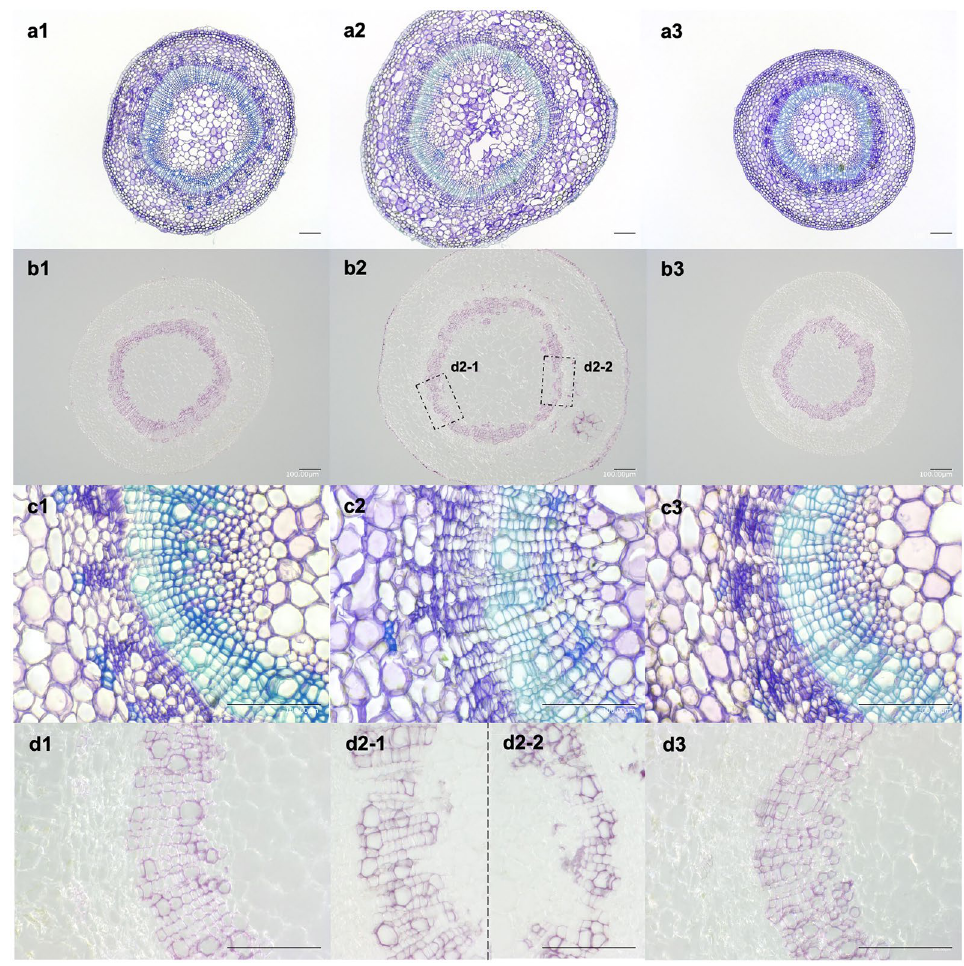
Fig. 6 Cross sections of basal stem of CWPO‑C transgenic poplar lines. a , c Toluidine blue staining. b , d Wiesner staining. a1 , b1 , c1 , d1 WT. a2 , b2 , c2 , d2 RNAi suppression line RNAi1. a3 , b3 , c3 , d3 Overexpression line OE1. Sections (20 μm thick) were prepared from the basal stem of 6‑week‑old plants. Bar 100